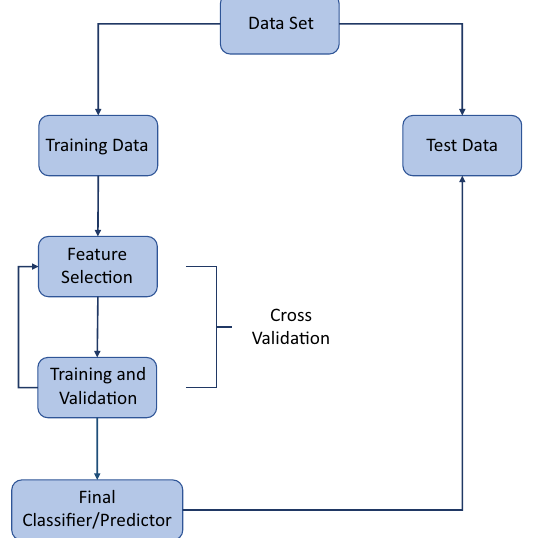
Fig. 2 Simpli fi ed work fl ow for developing a machine learning model. This includes the cycle of feature selection, training and validation that is required to avoid over fi tting (cross